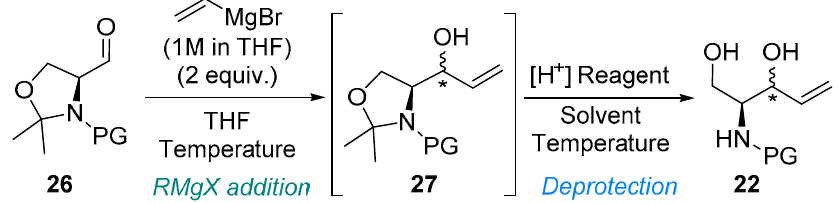
Scheme 6. Optimisation of the RMgX addition and deprotection reaction